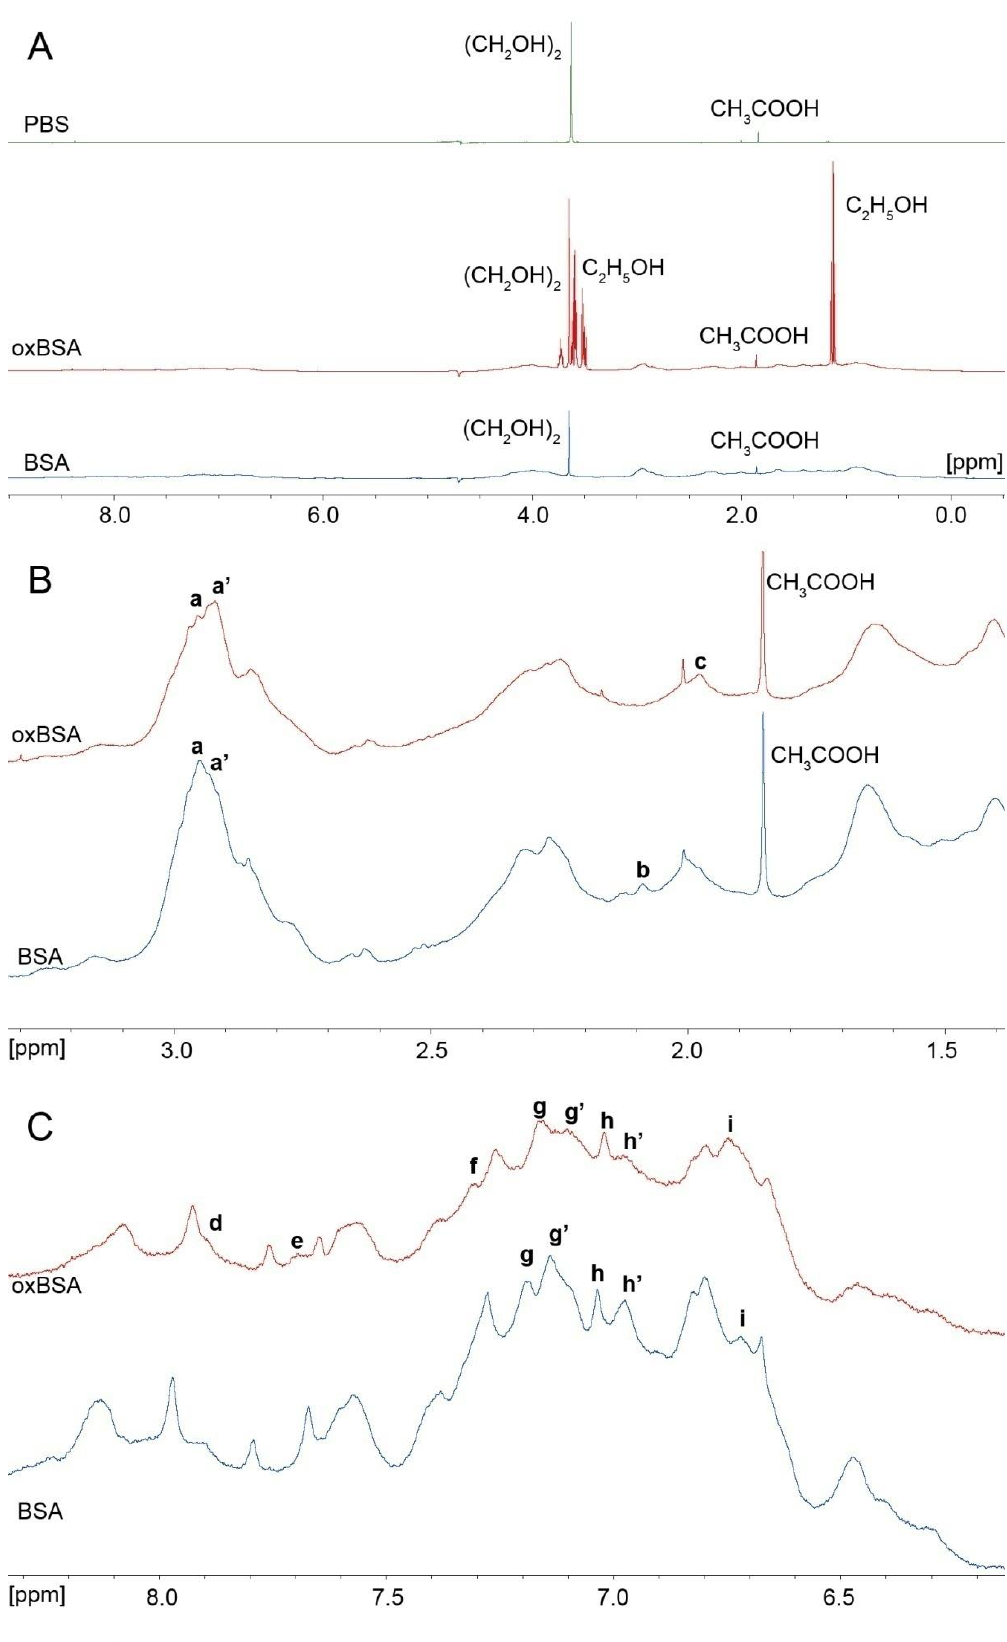
Figure 7. 1 H NMR spectrum of phosphate bu ff ered saline (PBS, green), commercial bovine serum albumin (BSA, blue) and BSA incubated with ethacrynic acid in a molar ratio of 1:5 (oxBSA, red). ( A ) Full spectrum. ( B ) Aliphatic region. ( C ) Aromatic